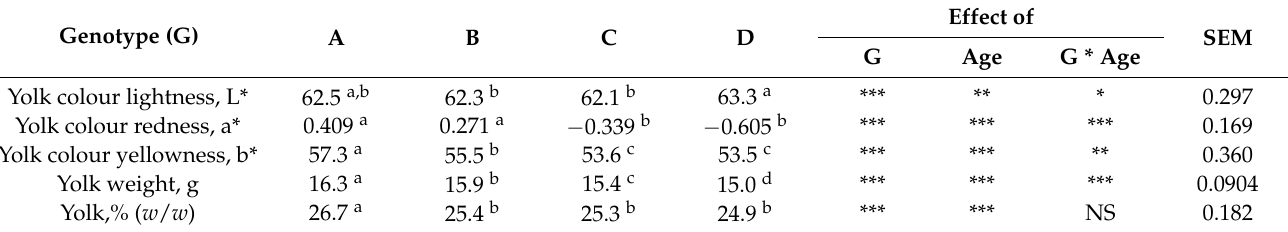
Table 3. Effect of hen genotype A, B, C, and D, age, and their interaction on LS-means of egg yolk parameters between the 21st and 54th week of age, n = 180 for genotype A and 270 for genotypes B, C and